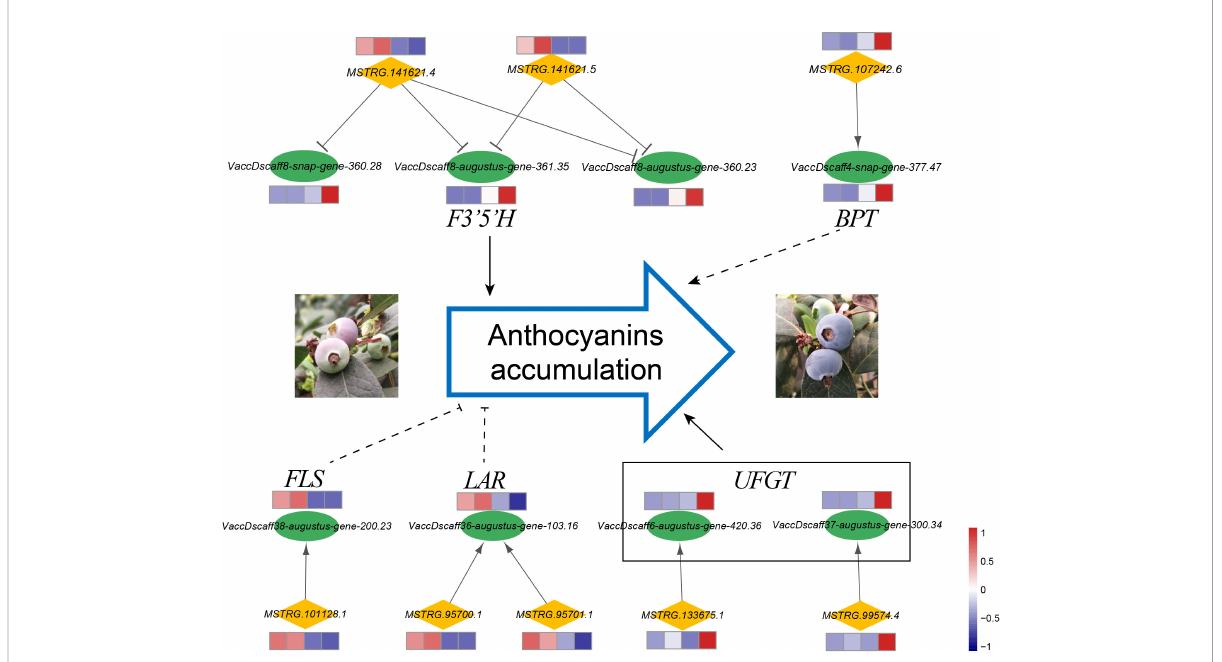
FIGURE 7 Cis -regulatory lncRNAs associated with anthocyanin accumulation. LncRNAs and protein-coding genes are indicated by orange diamonds and green ellipses, respectively. The expression patterns of transcripts are shown by heatmaps, and the expression levels at the four developmental stages are shown from left to right for each gene. The target genes were annotated as fl avonoid 3 ’ ,5 ’ -hydroxylase ( F3 ’ 5 ’ H ), BTB/POZ and TAZ domain-containing protein ( BPT ), fl avonol synthase ( FLS ), leucoanthocyanidin reductase ( LAR ), and UDP-glucose: fl avonoid 3- Oglucosyltransferase ( UFGT